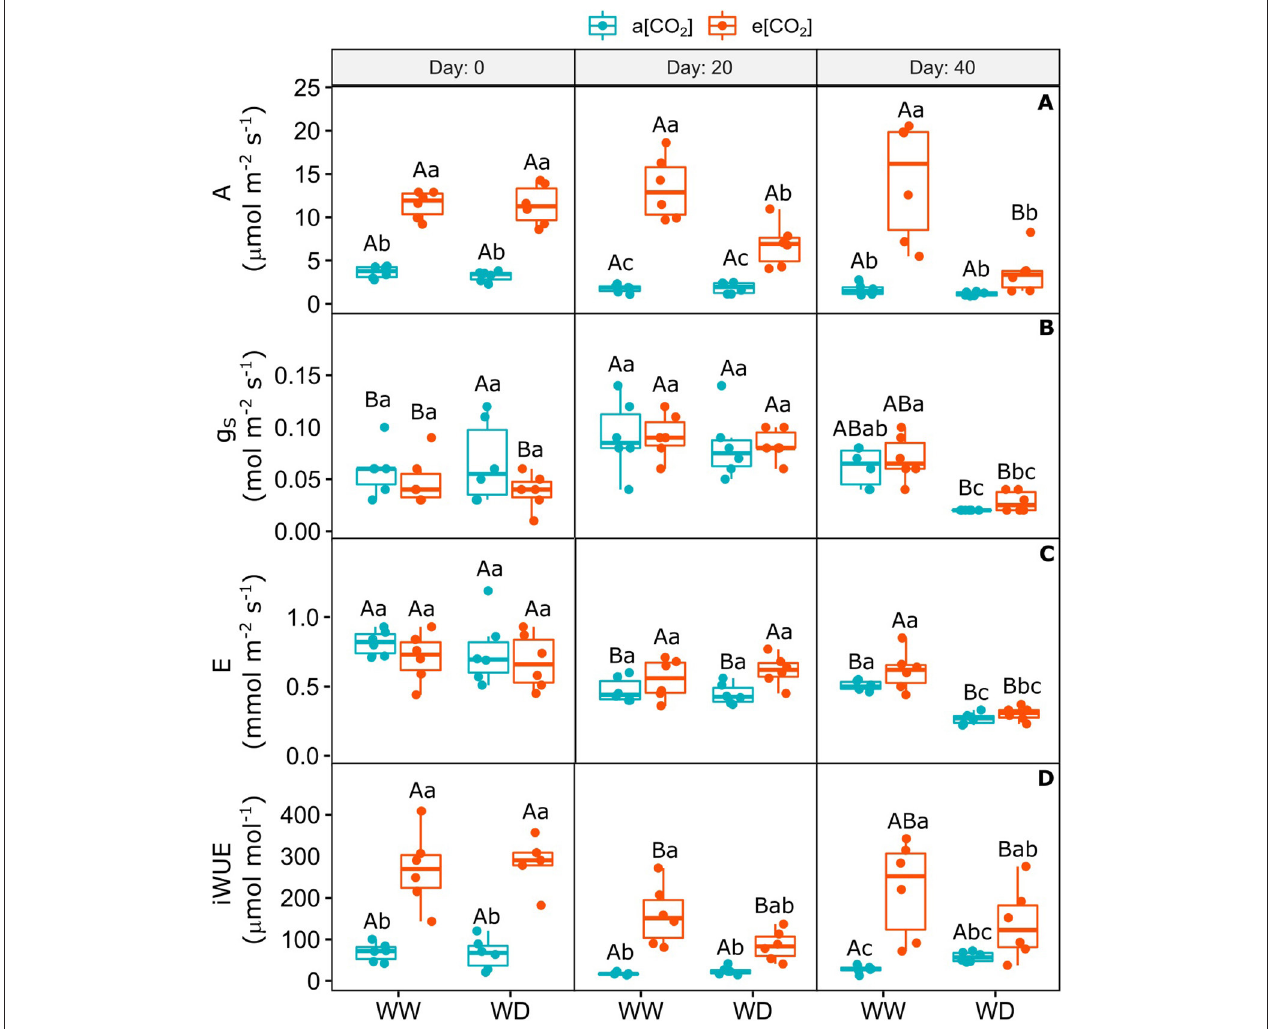
FIGURE 2 | Gas exchange of C. arabica plants exposed to ambient [CO 2 ] under well-watered and water deficit (a[CO 2 ] + WW and a[CO 2 ] + WD, respectively) and elevated [CO 2 ] under well-watered and water deficit (e[CO 2 ] + WW and e[CO 2 ] + WD, respectively) conditions on day 0, 20, and 40 after water deficit imposition in the OTC. (A) Net CO 2 assimilation, (B) Stomatal conductance, (C) Transpiration rate, and (D) Intrinsic water use efficiency. Boxes represent the median and first and third quartiles, symbols represent individual samples ( n = 6–5 biological replicates). Different capital letters represent significant differences between sampling day in the same water and [CO 2 ] condition, whereas different lowercase letters represent significant differences between water and [CO 2 ] conditions in the same sampling day according to Tukey’s test at 5% of probability ( P ≤